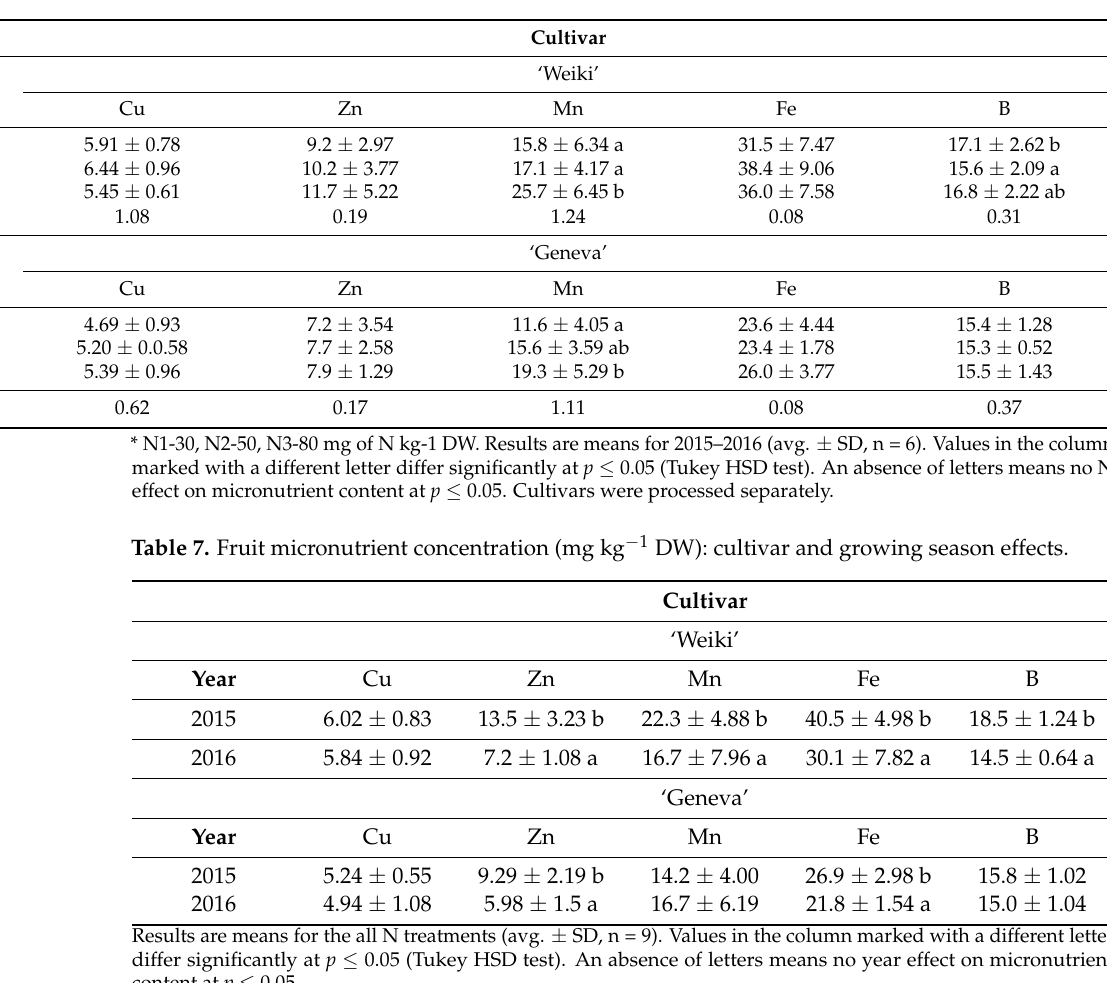
Table 6. Fruit micronutrient concentration (mg kg − 1 DW): cultivar and soil N effects.